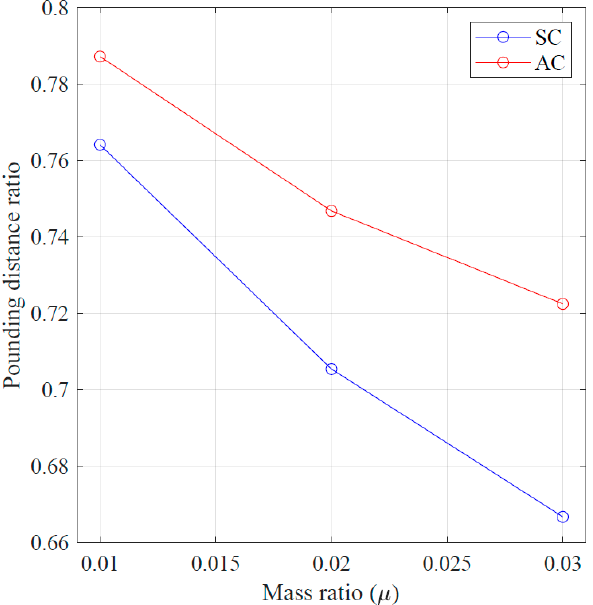
Figure 9. Ratio of pounding distance of the two buildings with controlled with STMD (SC) and building A controlled (AC) schemes to that of uncontrolled buildings.